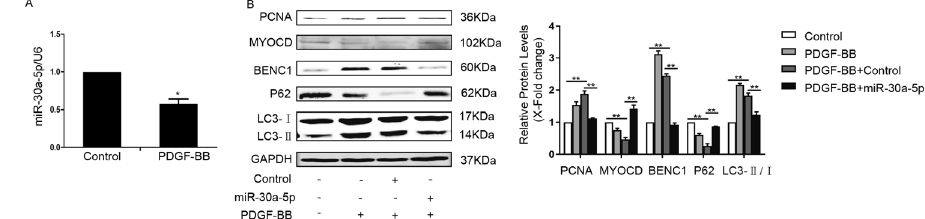
Fig. 6 Restoring the expression of miR-30a-5p in PDGF-BB-treated cells upregulated the level of contraction proteins. A Serum-starved HA-VSMCs were treated with 40 ng/mL PDGF-BB for 24 h, and then the level of miR-30a-5p was detected by qRT-PCR (* P < 0.05, n = 3). B Serum-starved HA-VSMCs were transfected with miR-30a-5p mimics for 4 h and then stimulated with 40 ng/mL PDGF-BB for 48 h. Western blot images and quanti fi cation in each group are shown (* P < 0.05, ** P < 0.01, n =